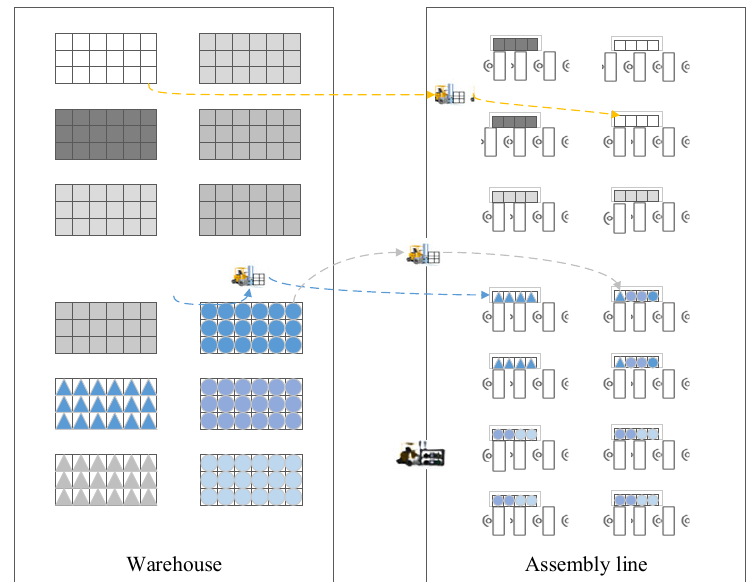
Fig. 1. The schematic diagram of the material distribution system in the assembly